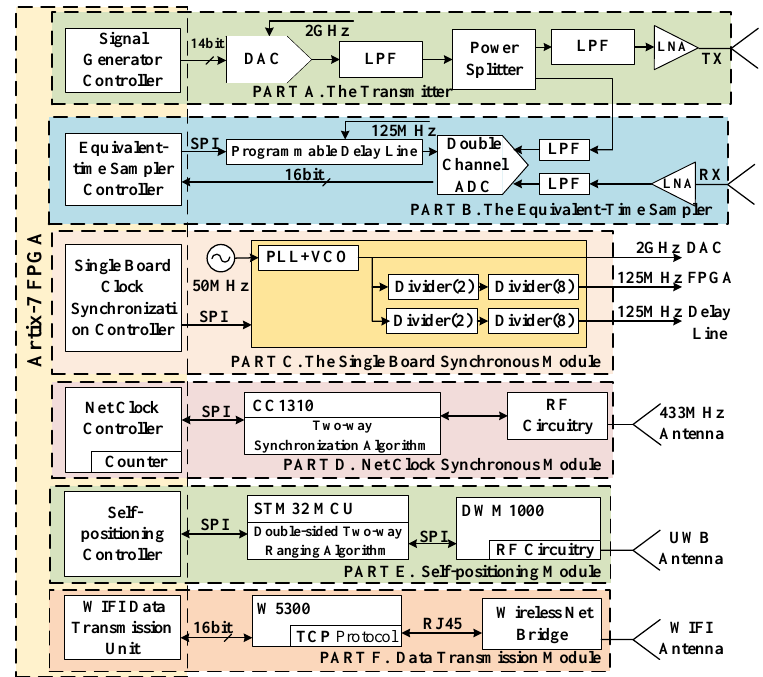
Figure 2. The block diagram of the Golay complementary coded radar. UWB: ultra-wideband.